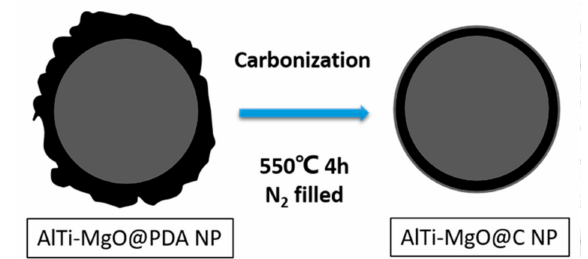
Figure 2. Schematic diagram of the formation of the carbon film after heat